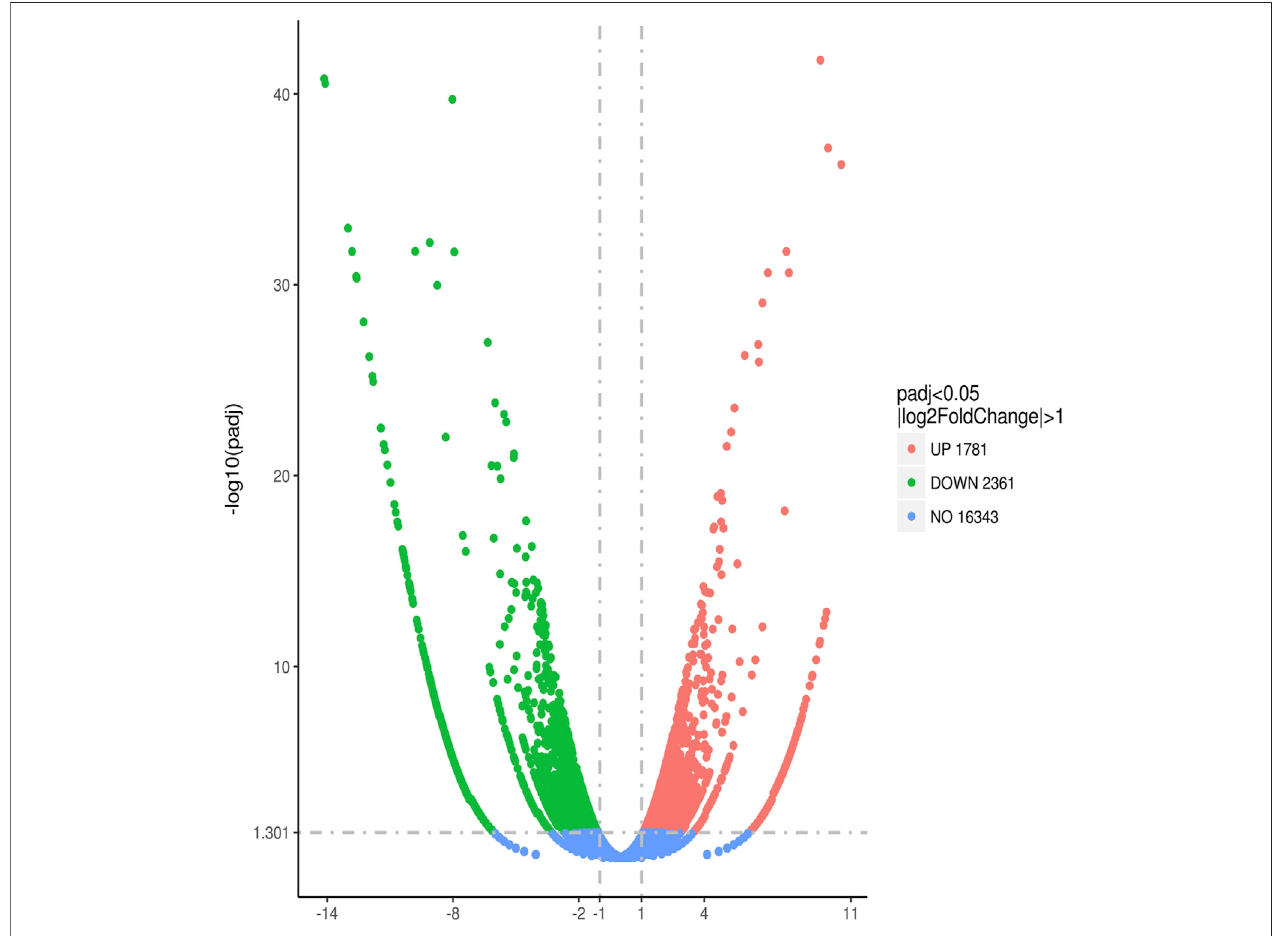
FIGURE 3 | Quantitative comparison of gene expression levels in aortic macrophages of mice with dyslipidemia: PDR group vs. SKYD group.